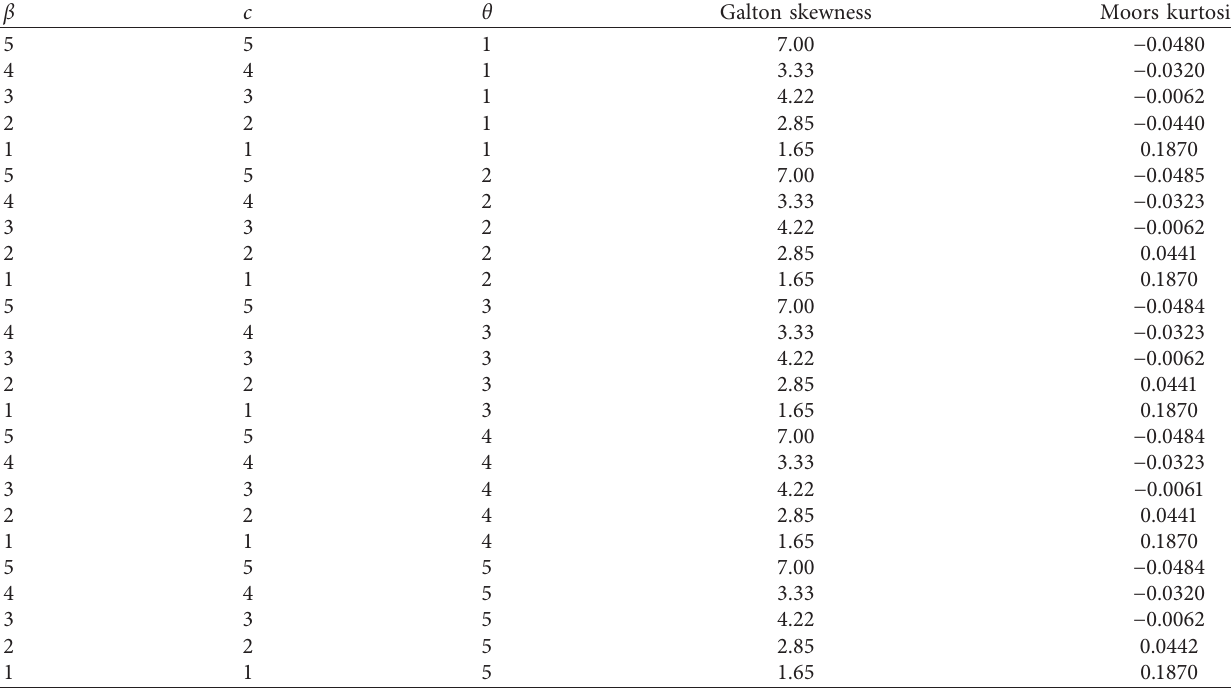
Table 1: Moors kurtosis and Galton skewness for GWL distribution at different parameter combinations. β c